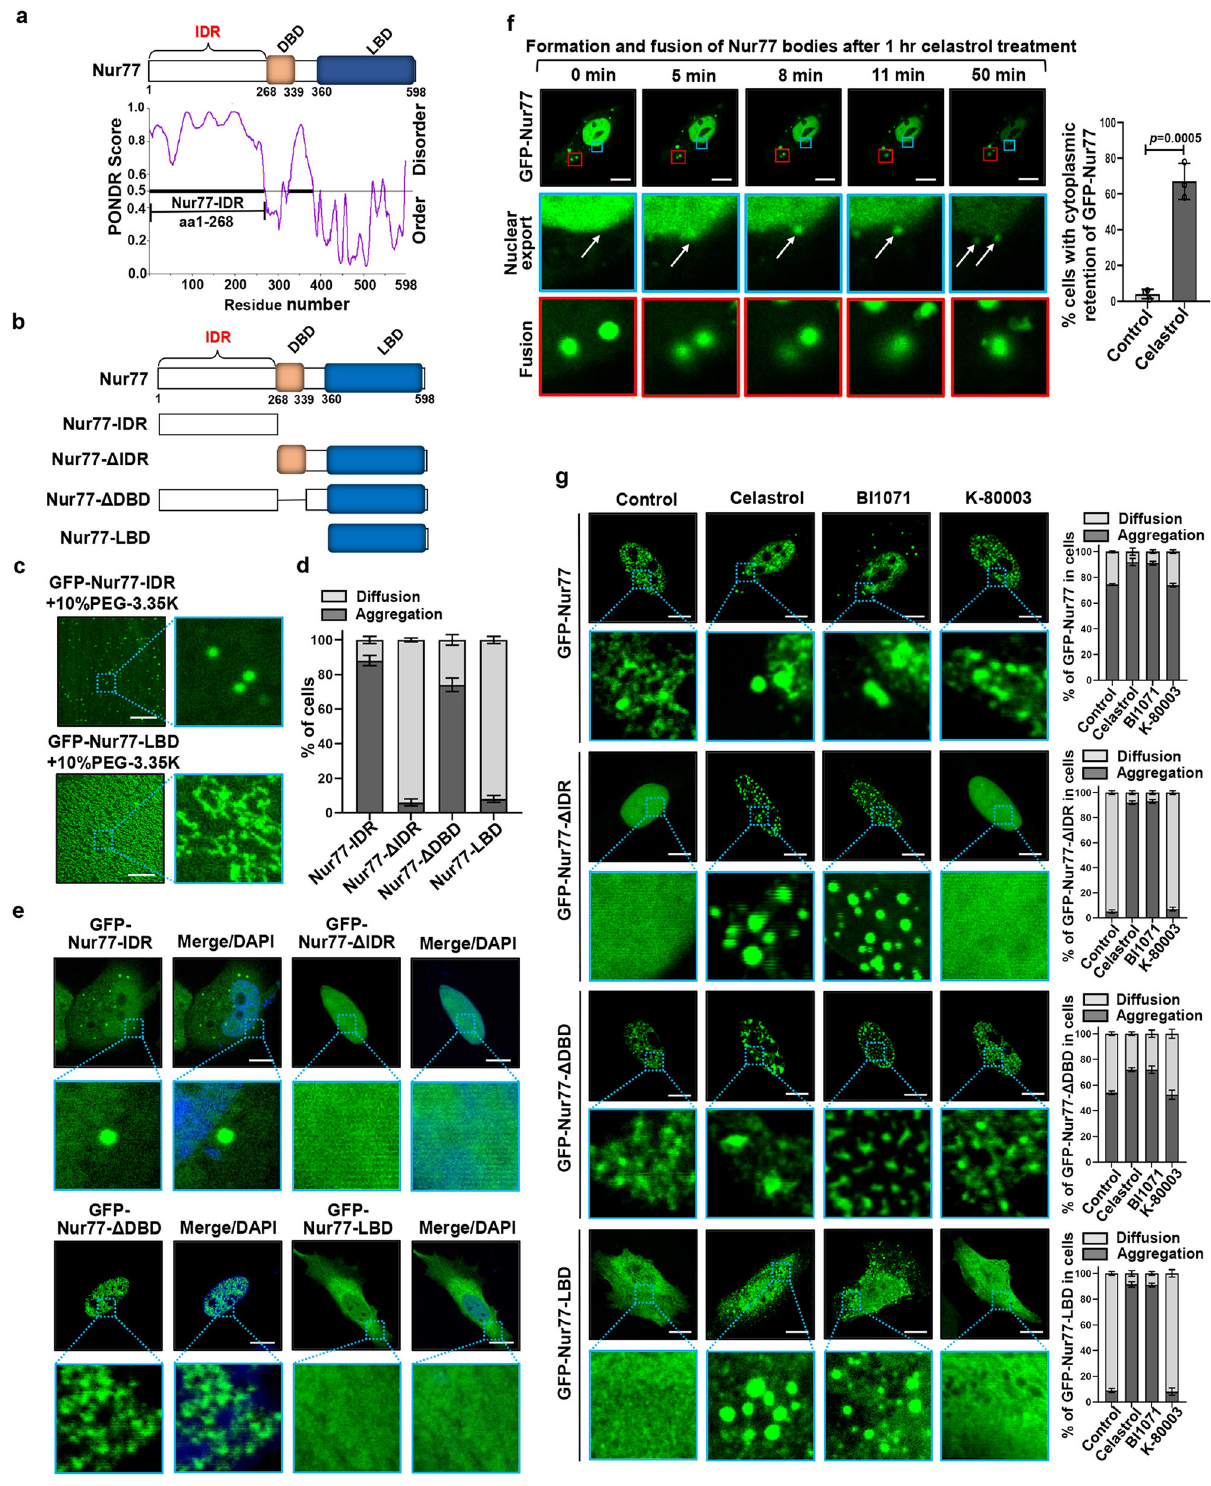
displaying spherical shell structure (Supplementary Fig. 5a). TRAF2-mediated Nur77 ubiquitination likely plays a role in p62 body formation as celastrol-induced Nur77 condensates coloca- lized not only with p62 but also with ubiquitin (Fig. 5a). To con fi rm the role of Nur77 ubiquitination, we mutated its ubi- quitination site and tested its effect on p62 body formation. Mutating Lys536 in Nur77 (Nur77-K536R) (Fig. 5b) or Nur77- LBD (Nur77-LBD-K536R) (Fig. 5c) impaired the effect of